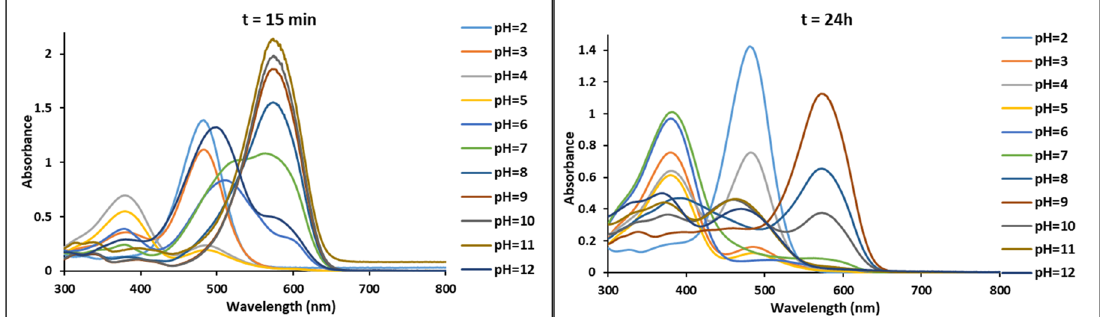
Figure 7. UV–Vis spectra of dye 2 in different pH buffer solutions (3.8 × 10 − 5 M in methanol: water 1:9).